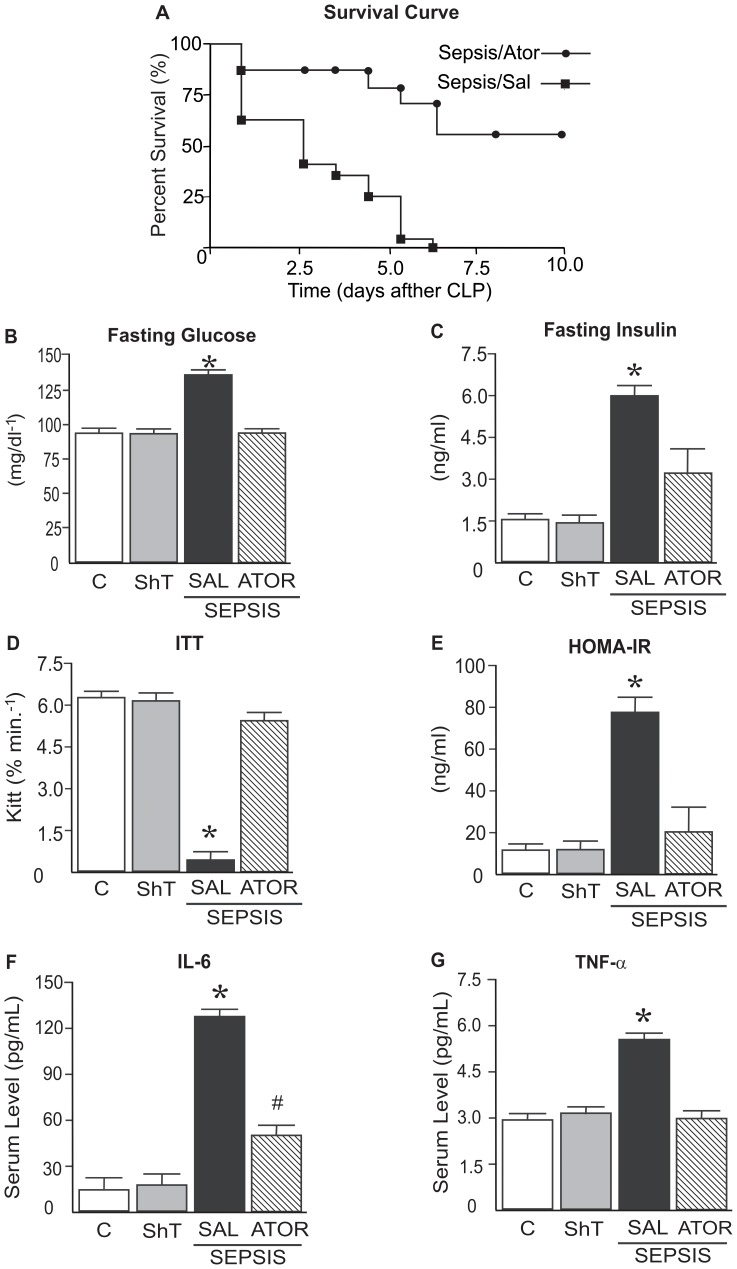
Effect of atorvastatin on survival in CLP sepsis model.Male Wistars rats, 8 weeks old, were given saline (Sepsis/Sal, n = 20) or atorvastatin 10 mg/kg (Sepsis/Ator, n = 20), 3 h and once a day after CLP. Survival of the rats was monitored at intervals of 12 h for 15 days. The overall difference in survival rate between the groups with and without atorvastatin was significant (P<0.0001) (A). Fasting blood glucose (B). Fasting insulin levels (C). Glucose disappearance rate (D). HOMA-IR index (E). Serum levels of TNF-α (F) and IL-6 (G). Data are presented as means and S.E. of six to eight rats per group. *P<0.05 (Sepsis saline vs. all others groups).